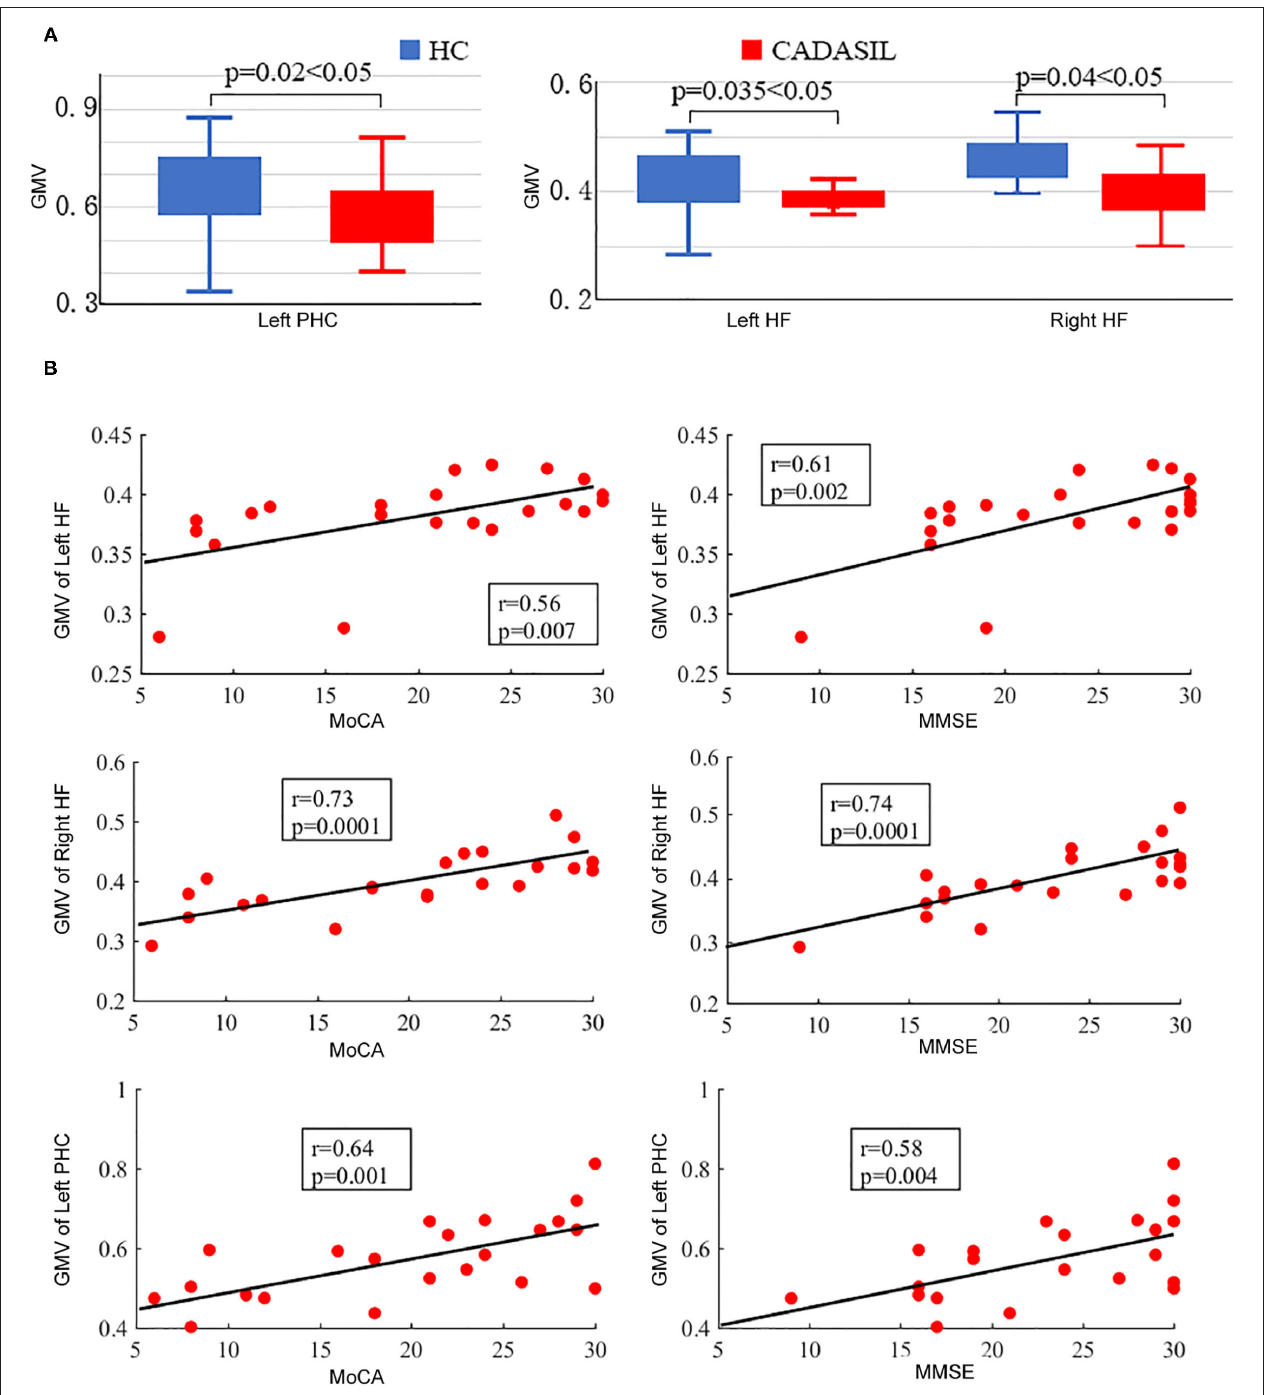
FIGURE 3 | Results of GMV analysis in CADASIL and control groups. (A) Alterations in GMV of the DMN in CADASIL. Patients with CADASIL had decreased GMV in the left PHC and bilateral HF compared with healthy controls. (B) Correlations between GMV of ROIs within the DMN and cognitive scores in CADASIL. GMV, gray matter volume; CADASIL, cerebral autosomal dominant arteriopathy with subcortical infarcts and leukoencephalopathy; DMN, default mode network; PHC, parahippocampal cortex; HF, hippocampal formation; ROI, region of interest; HC, healthy control; MoCA, Montreal Cognitive Assessment; MMSE, Mini-Mental State